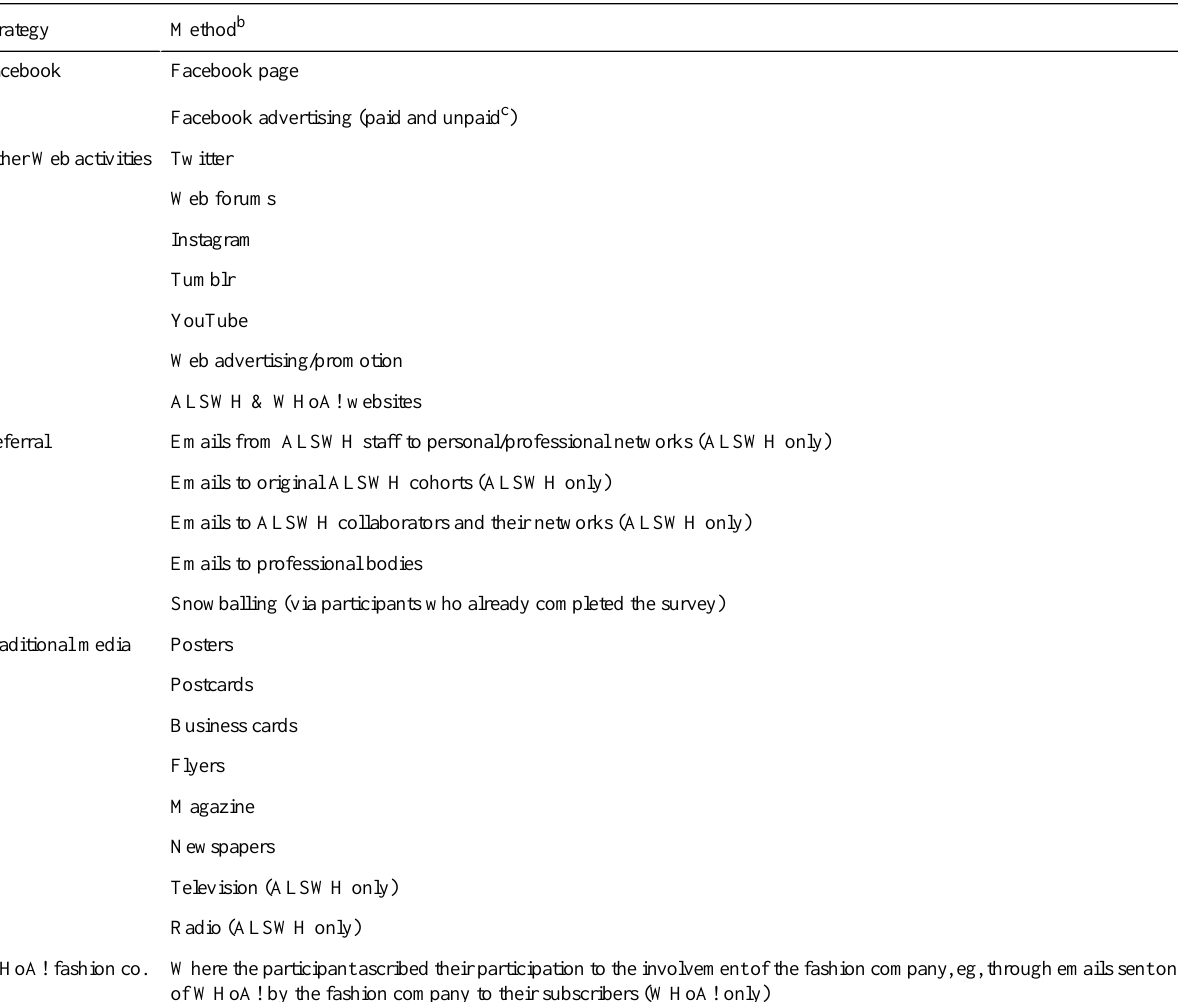
Table 1. Strategies used to recruit the ALSWH 1989-95 cohort over the recruitment period October 2012 to December 2013.